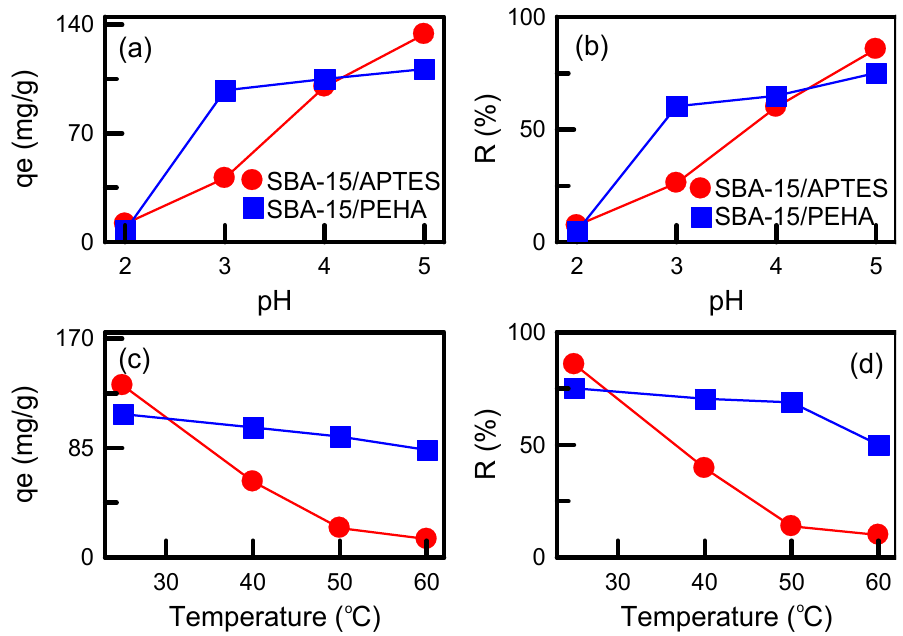
Figure 10. Effects of various adsorption conditions on the adsorption capacity and removal efficiency of adsorbents: ( a , b ) Solution pH; ( c , d ) solution temperature.